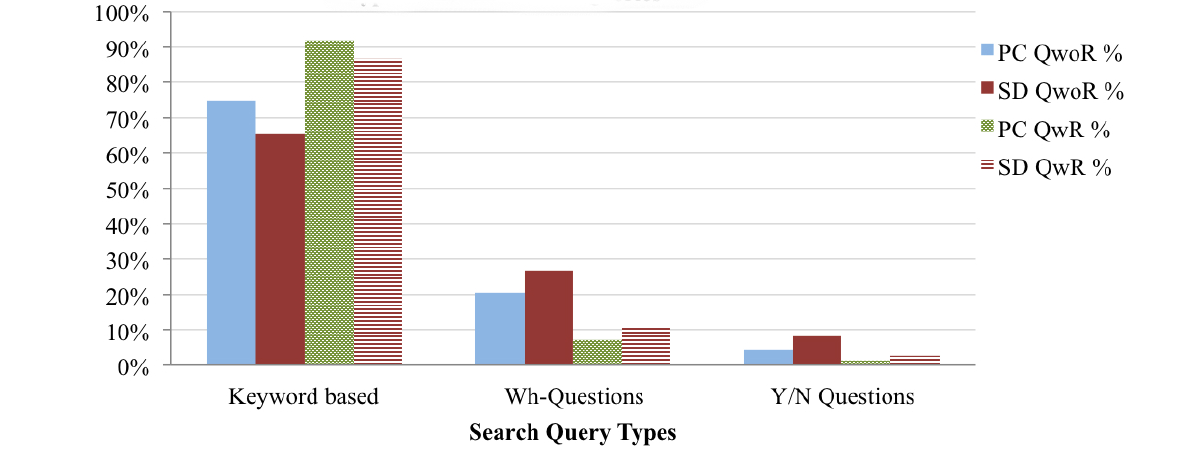
Figure 5. Types of health search queries (how health information need is expressed).